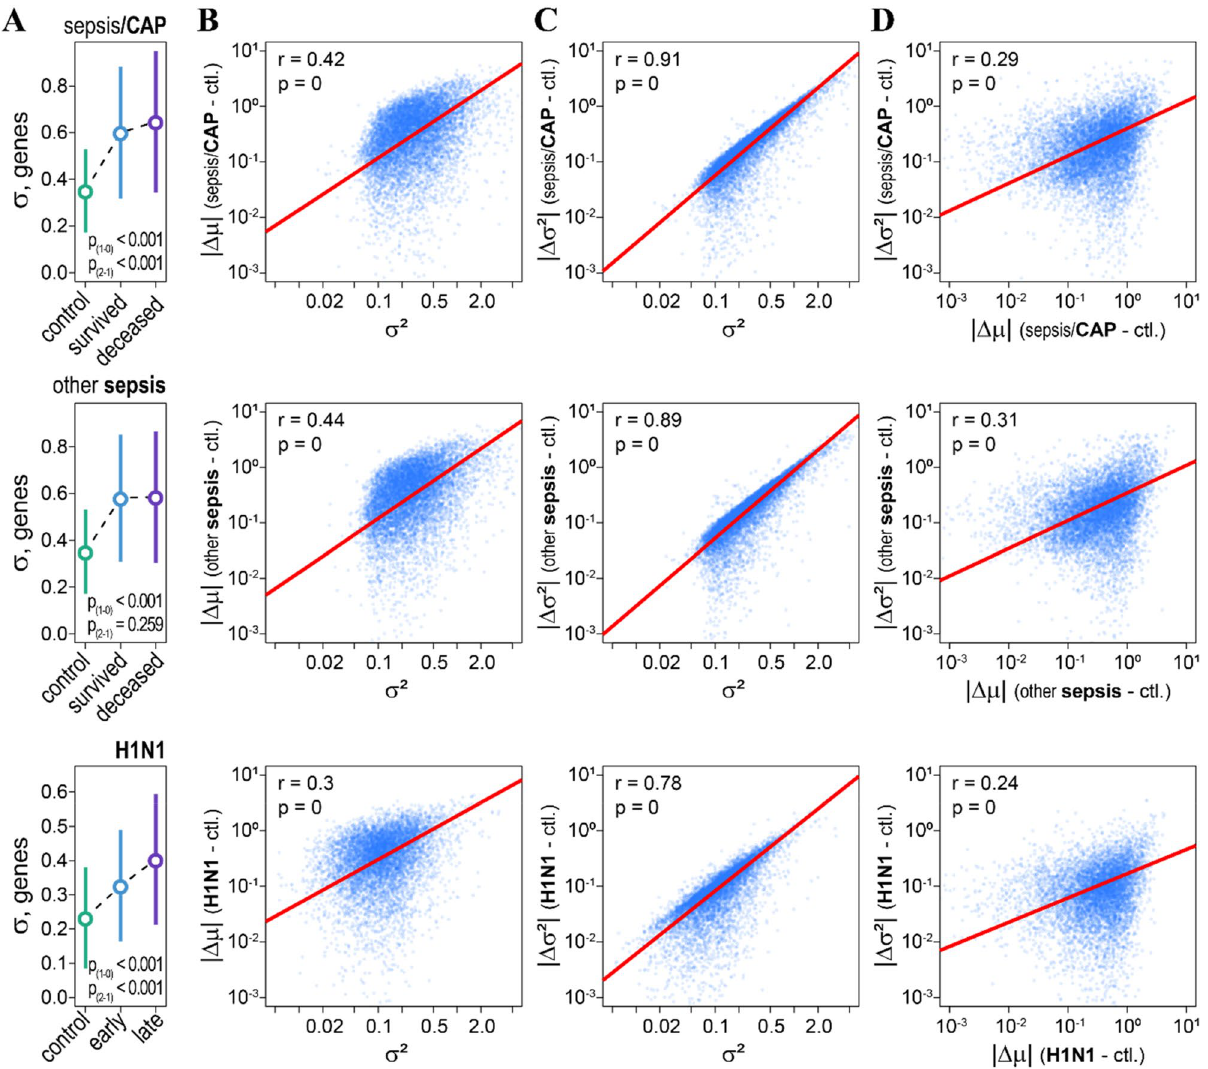
Figure 1. H1N1 and sepsis coordinately affect mean gene expression and inter-individual gene expression variability. ( A ) Inter-individual variability in whole blood gene expression (σ) increases in sepsis/CAP (top), other sepsis (mid), and H1N1 (bottom) patients as compared to healthy individuals. p (1–0)— p -values of t- tests comparing differences in inter-individual gene expression variability of healthy individuals (control) with survived (sepsis) and early H1N1 infected patients. p (2–1)— p -values of t- tests comparing differences of survived (sepsis) and early H1N1 infected patients with deceased (sepsis) and late H1N1 infected patients. Circles and whiskers indicate means and standard deviations respectively. ( B ) Correlations between variances in whole blood gene expression (σ 2 ) and absolute changes in mean gene expression (|Δμ|) for healthy individuals (ctl.) and patients (sepsis, H1N1). Due to the fluctuation-response relationship, the magnitude of the mean gene expression response depends on its variance. We estimated common variances for genes in healthy and sepsis/ CAP patients (top), healthy and other sepsis patients (mid), and healthy and H1N1 patients (bottom). ( C ) Correlations between variances in whole blood gene expression (σ 2 ) and absolute changes in inter-individual gene expression variability (|Δσ 2 |) for control individuals (ctl.) and patients (sepsis, H1N1). ( D ) Correlations between absolute changes in mean gene expression (|Δμ|) and in inter-individual gene expression variability (|Δσ 2 changes in both the mean and the heterogeneity of the expression of genes and that magnitudes of these changes depend on the genes’ biological coefficients of variation. Gene ensemble noise response to infection and sepsis. Both the mean and variance relate to popu- lation (inter-individual) statistics reflecting distinct aspects of gene regulation. Changes in means fit the classi- cal DGE view on gene response to pathology and other biological processes, while changes in variances yield a view on the heterogeneity of the gene response. However, as noted before (Fig. 1 and S1), statistical inference of these changes is biased towards higher significance for genes with a high biological coefficient of variation.